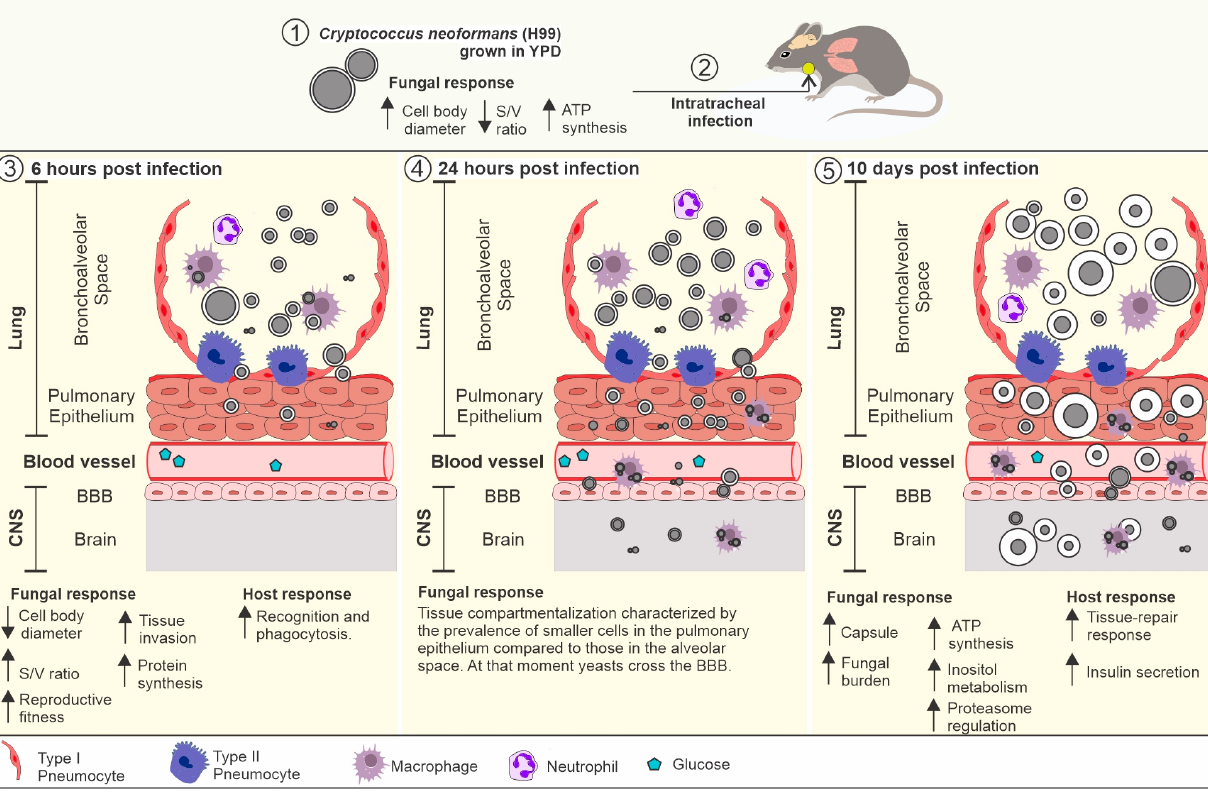
Figure 7. The dynamics of Cryptococcus neoformans cell remodeling during infection. ( 1 ) The growth of the H99 strain on YPD resulted in cells with a larger cell body diameter (mean: 5.6 µm), reduced capsule (mean: 0.5), reduced surface-to-volume ratio (mean: 1.16), and upregulation of pathways related to energy production. This profile mimics yeasts found in the environment. ( 2 ) After mice intratracheal infection with these cells, we observed a time- and location-dependent cell remodeling. ( 3 ) At 6 h post infection, we observed a predominance of small cells in the BS compared to the initial size. These cells have a smaller cell body and a higher surface-to-volume ratio. This contributes to increased fitness and pulmonary epithelium invasion. This cellular profile was associated with upregulation of pathways related to protein synthesis and upregulations of recognition and phagocytosis pathways in the host. ( 4 ) At 24 h post infection, we observed tissue compartmentalization characterized by the prevalence of smaller cells in the pulmonary epithelium (variation: 1.0–4.0 µm) compared to cells in the BS (variation: 1.0–12.0 µm). This evidence confirmed our hypothesis that small cells are important for PE invasion during interaction with the host. At this stage, the cells were able to reach the bloodstream, free or internalized by phagocytes, and cross the blood–brain barrier (BBB) and infect the central nervous system (CNS). ( 5 ) At 10 days post infection, we observed an increase in the polysaccharide capsule and upregulation of pathways related to energy production, inositol, and proteasome metabolism. In the host, this cellular profile led to the upregulation of tissue repair pathways and insulin secretion.